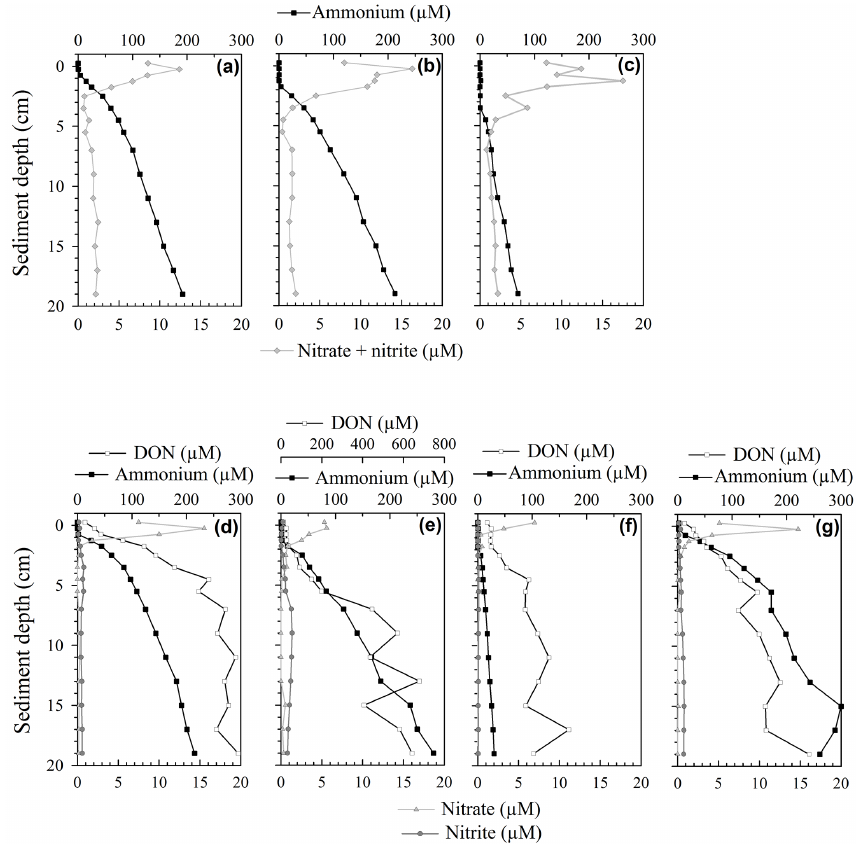
Figure 3. Pore-water concentration profiles of ammonium, nitrate, nitrite, and dissolved organic nitrogen (DON) as a function of depth in the sediment of GOB1 (a) , GOB2 (b) , and GOB3 (c) in 2013, and GOB1 (d) , GOB2 (e) , GOB3 (f) , and RA2 (g) in 2014. Values on top of each profile represent bottom-water samples. Note a second x axis with different scale for (e) .